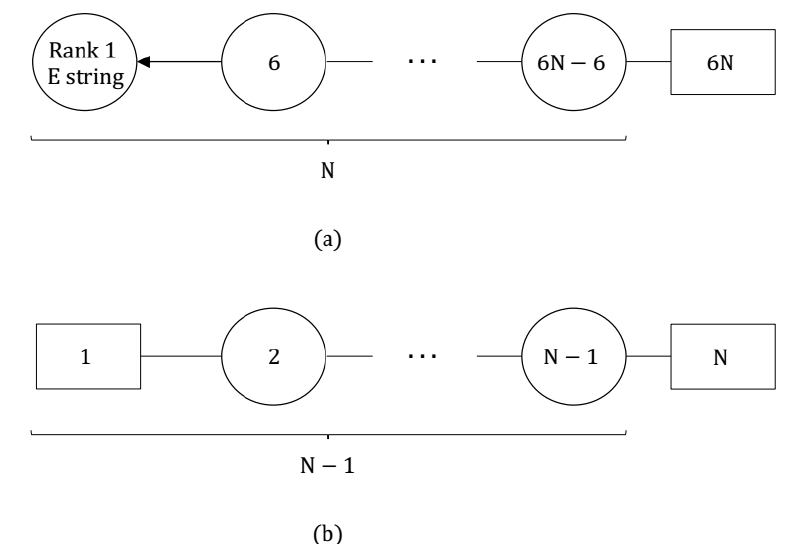
Figure 9 . (a) A 6 d quiver describing a 6 d SCFT on a generic point on the tensor branch. (b) The Quiver of the 4 d gauge theory that is expected to exist, on a generic point on the Coulomb branch spanned by the operators descending from the tensor multiplets, for the theory resulting from the SW compacti(cid:12)cation of the theory in (a).